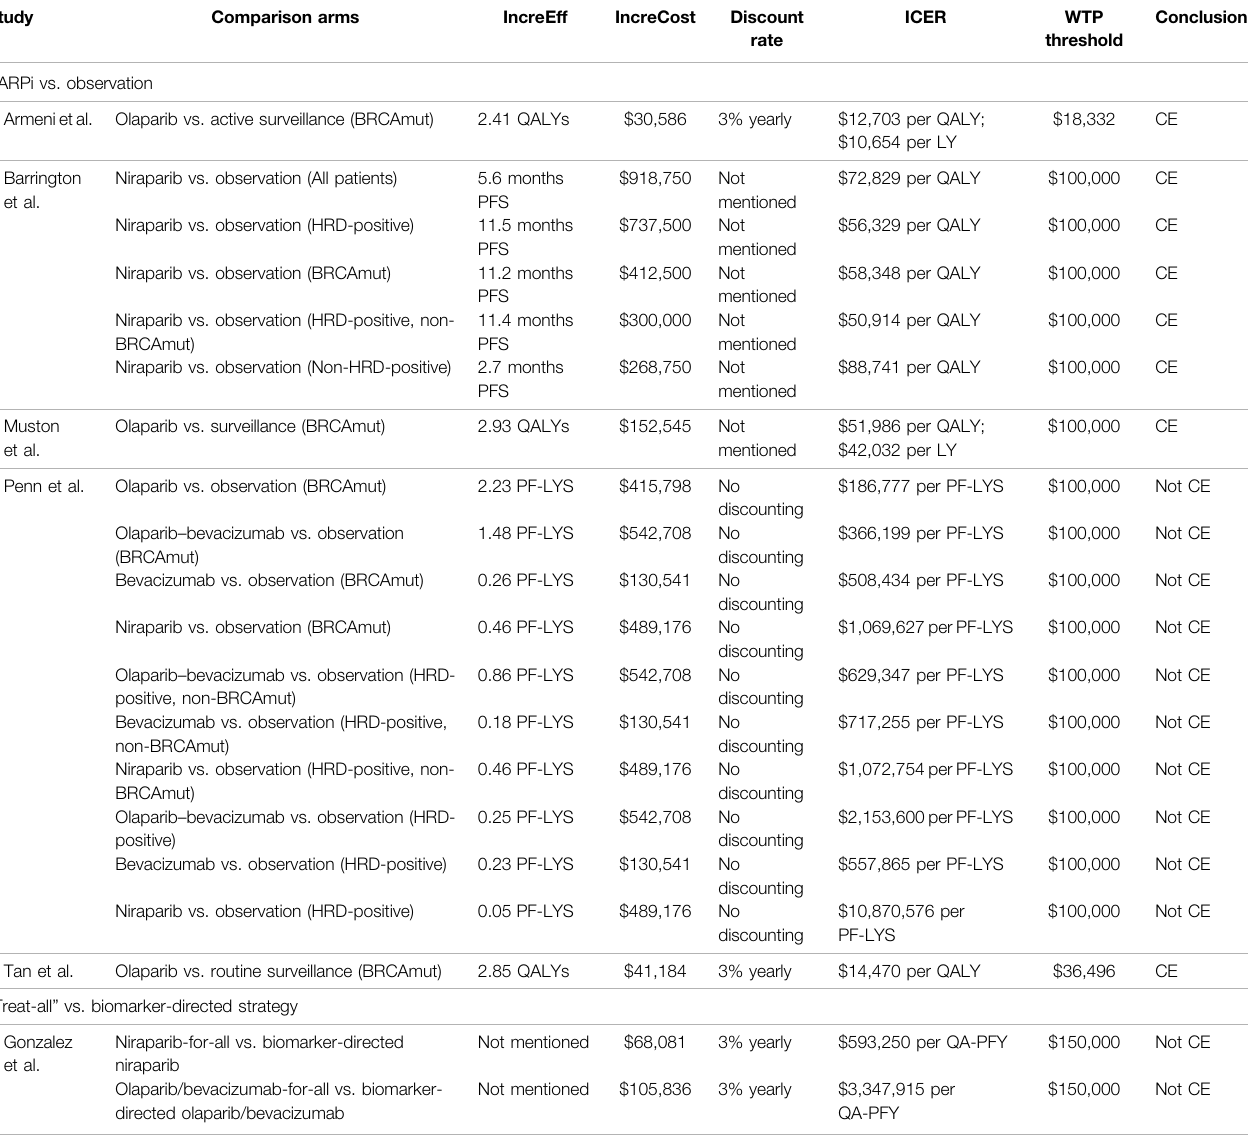
TABLE 3 | Details of economic evaluation outcomes of studies in newly diagnosed advanced ovarian